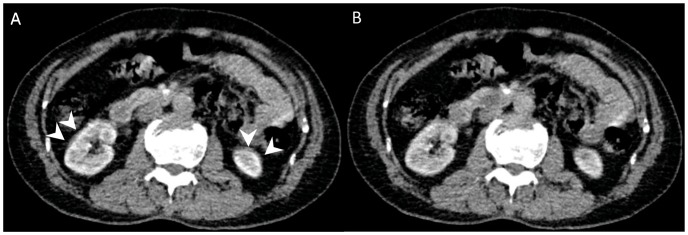
Transverse contrast-enhanced CT scan showed the effect of motion correction.Motion artifacts were seen as blurring of the kidney contours (arrowheads in A). Most motion artifacts were not seen after correction (B).